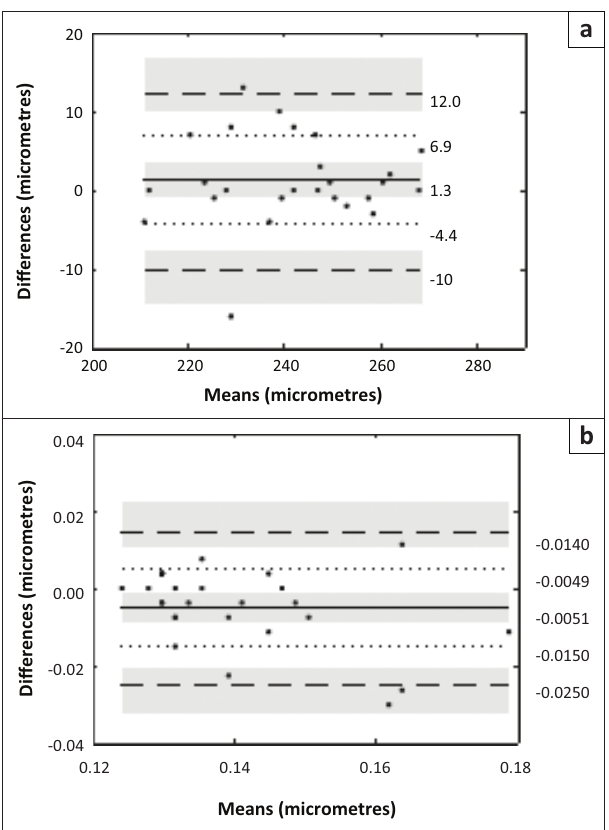
FIGURE 7: Bland–Altman plots of test and retest means versus differences for retinal thickness measurements at the fovea (central subfield/fovea) and oscillatory threshold at the fovea (point 5) for the sample ( n = 26). (a) Bland-Altman thickness for central subfield/fovea ( r = 0.043, p = 0.83) and (b) oscillatory threshold of Point 5 (central subfield/fovea) ( r = –0.38, p =